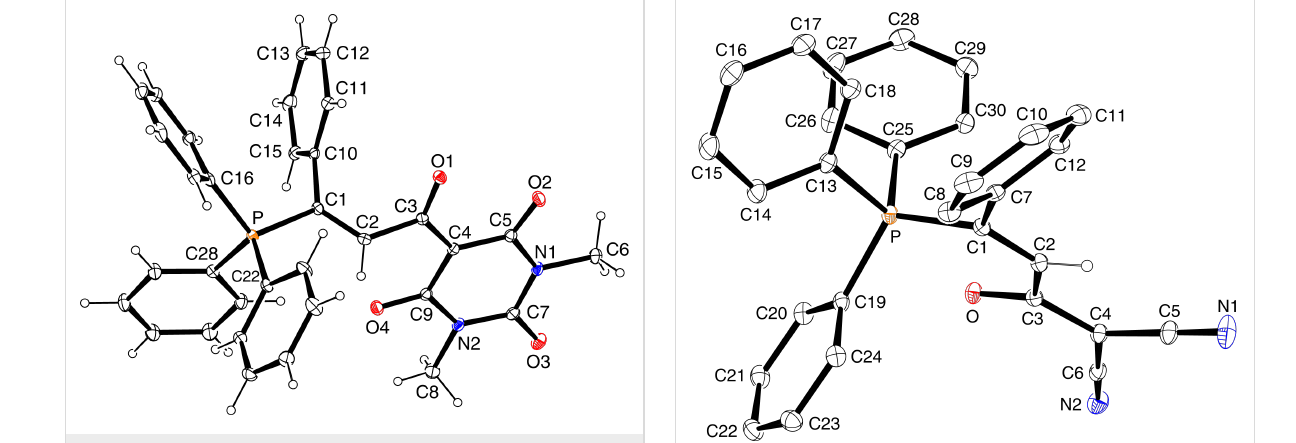
atoms in the CXY fragment of some betaines (mainly those with X = Y = CN) also indicates that free rotation around the C3–C4 bond is slow on the NMR time scale around 295